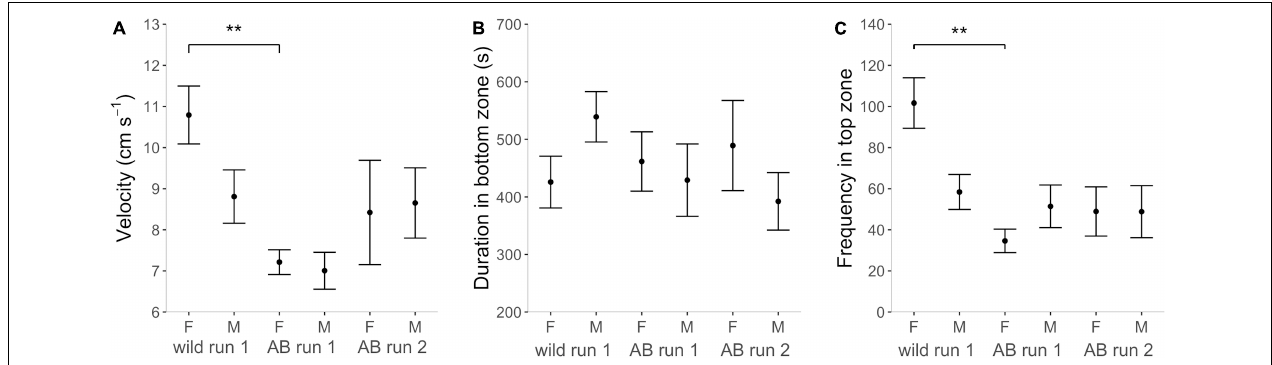
FIGURE 5 | Behavior in the novel tank diving test (NTDT). (A) Velocity (cm s - 1 ) in the whole arena, (B) duration (s) in the bottom third of the arena for the experimental groups, and (C) frequency of entries into the top third (from left to right in each graph) wild females, wild males, AB females run 1, AB males run 1, AB females run 2 and AB males run 2. Note that this figure combines the “strain” and “retested” datasets which were analyzed in two separate models per response variable, see methods section “Statistical Analyses.” Brackets with stars indicate significance with ** p <